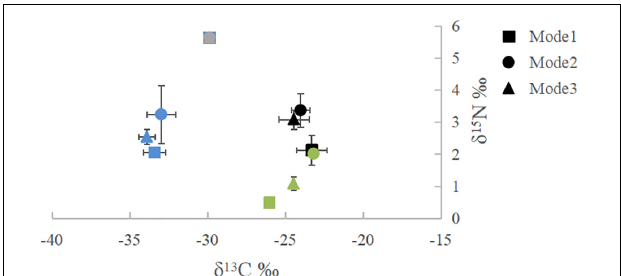
FIGURE 5 | Isotopic compositions of 13 C and 15 N stability of muscles and possible feed sources under the traditional, formulated, and mixture feeding modes. Error bars are ± SD. Mode1, 2, and 3 represent traditional, formulated, and mixted feeding modes, respectively. Color of symbol denotes different sources: black are muscle samples; gray are Alternanthera philoxeroides samples; bule are particulate organic matter (POM) samples; green are feed samples.